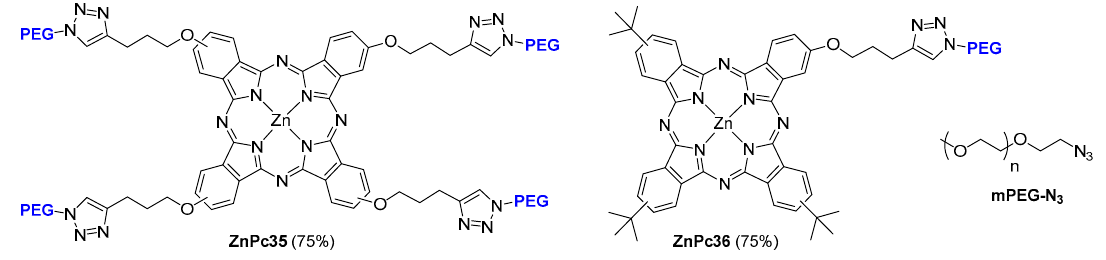
Figure 4. Structures ZnPc35 and ZnPc36 and of the azide mPEG-N 3 used in their preparation.